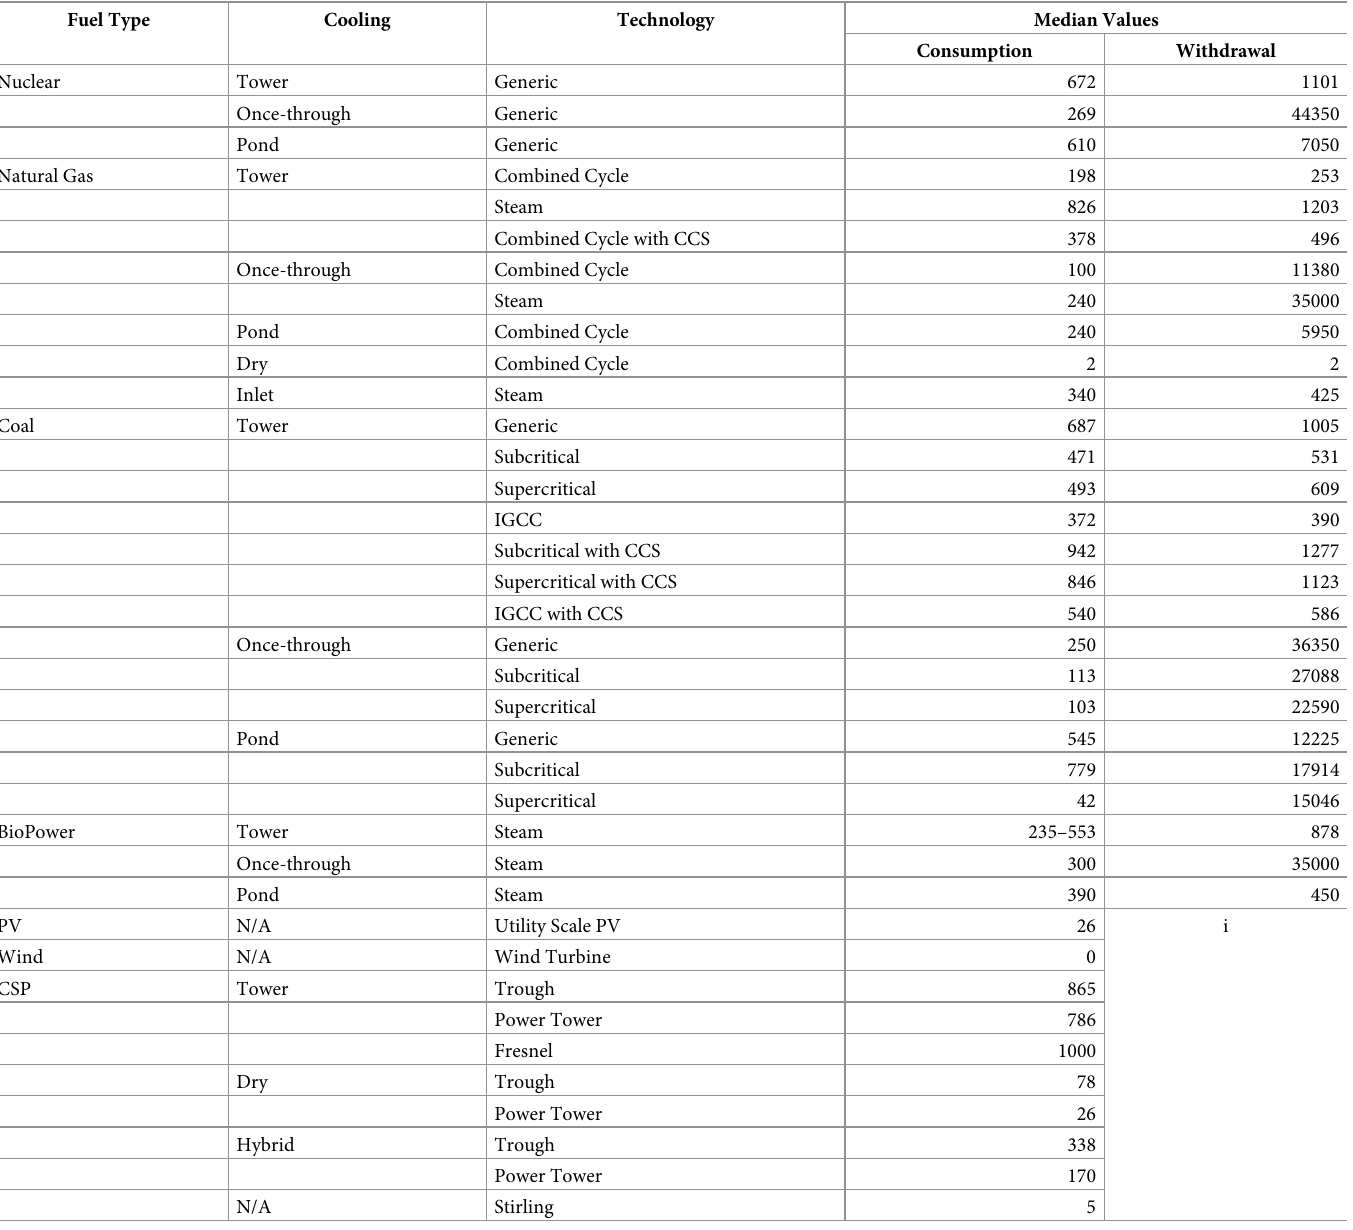
Table 2. Water Use Factors for Electricity Generating Technologies